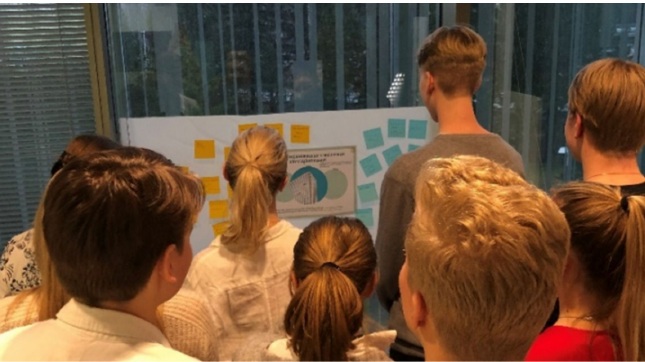
Figure 2. Youth discussing the workshop results related to their future mobility needs and